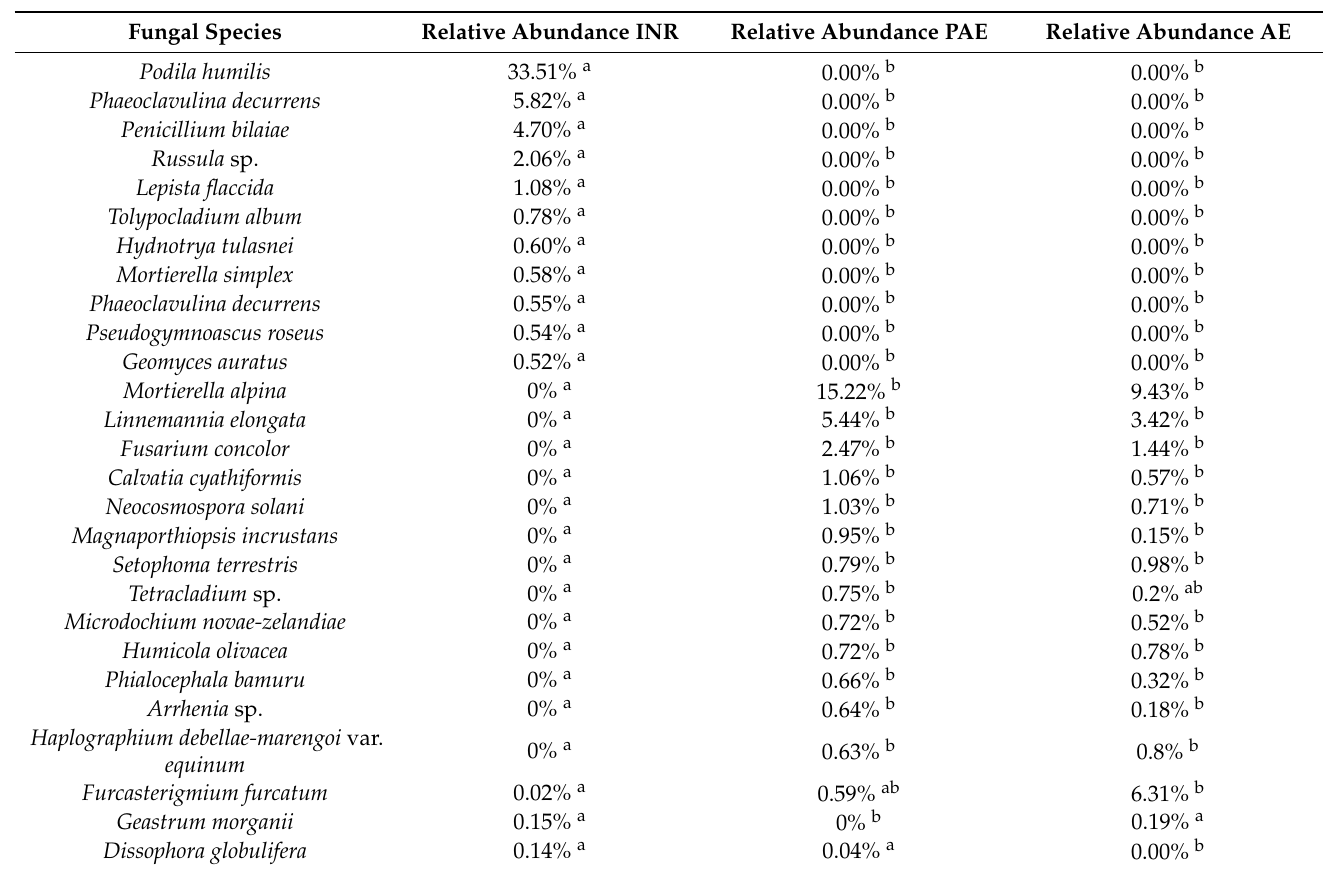
Table 5. List of fungal species with differential abundance in at least one site (differential expression analysis based on the negative binomial distribution, p -values < 0.05, adjusted by false discovery rate). Values with different letters in the same line are significantly different ( p < 0.05, ANOVA